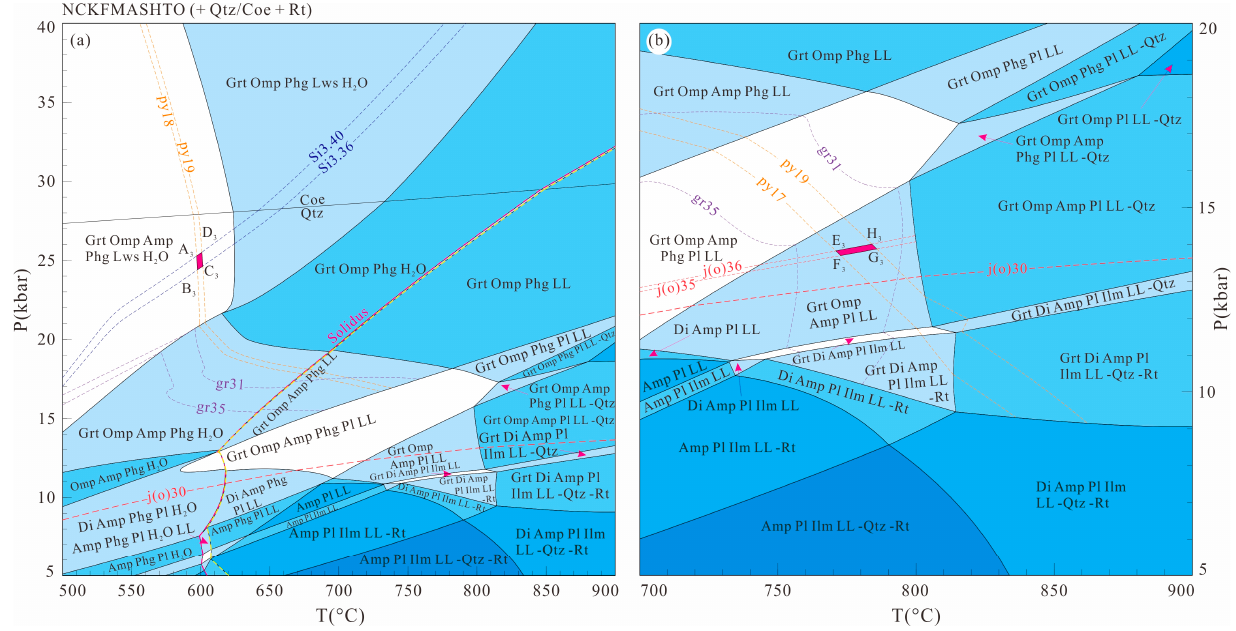
Figure 8. ( a ) P-T pseudosection for sample G-11 calculated with the bulk-rock composition. ( b ) P-T pseudosection for sample G-11 calculated with an effective bulk composition generated according to mass balance constraints from garnet rim and other relevant minerals. The compositions used for modelling are listed in Table 1. Other details are the same as Figure 7.